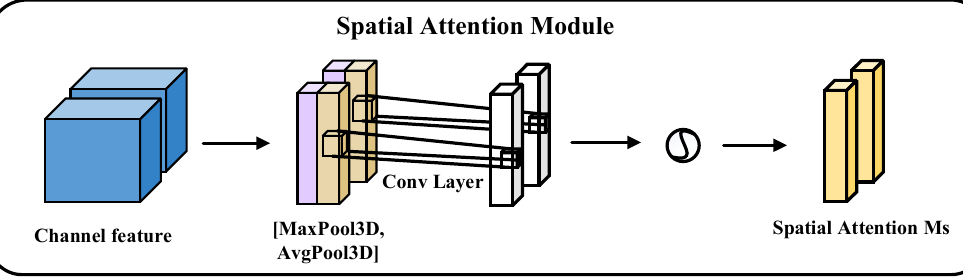
Figure 5. Spatial attention module.